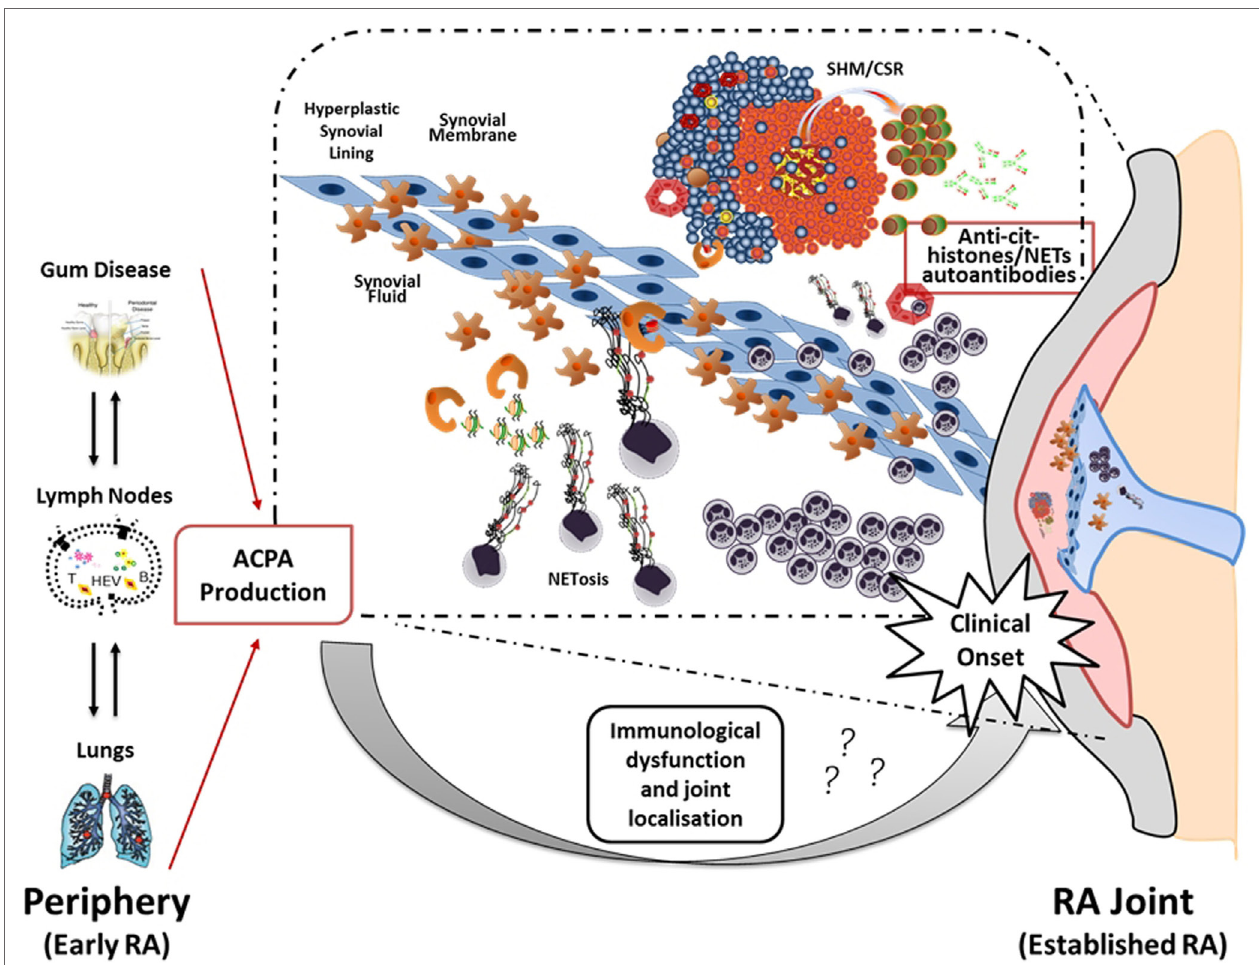
FiGURe 2 | Neutrophil NeTosis and anti-NeT antibodies in synovial eLS: a new model suggesting linking inflammation and autoimmunity to citrullinated proteins in RA . The figure illustrates the hypothetical evolution of ACPA from a pre-disease phase outside the joint to a disease phase associated with chronic synovial inflammation. In particular, it has been proposed that environmental factors such as bacterial infection in periodontal disease and smoking can lead to the formation of citrullinated antigens outside the joint which, in the context of HLA-DRB1 shared epitope, can lead to the production of ACPA prior to the clinical onset. However, the second inflammatory hit that occurs in the synovium is not clear yet. Here, we proposed that migration of neutrophils from the periphery followed by aberrant neutrophil NETosis during chronic inflammation within the RA compartment (synovial tissue and fluid) provide a continuous source of externalized citrullinated antigens, such as citH2A, citH2B, and citH4 histones that can be presented by antigen-presenting cells following engulfment of neutrophils nuclear fragments. Such process would sustain an antigen-driven autoimmune response toward citrullinated antigens within ELS in the RA joint resulting in the production of anti-NET autoantibodies, which may contribute to the perpetuation of chronic inflammation and autoimmunity